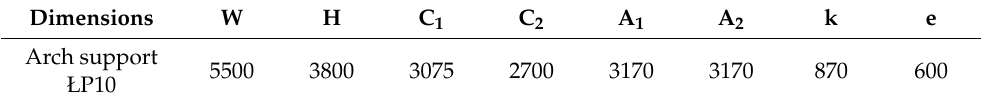
Table 2. Dimensions of the three-piece yielding arch support type ŁP10 [25].